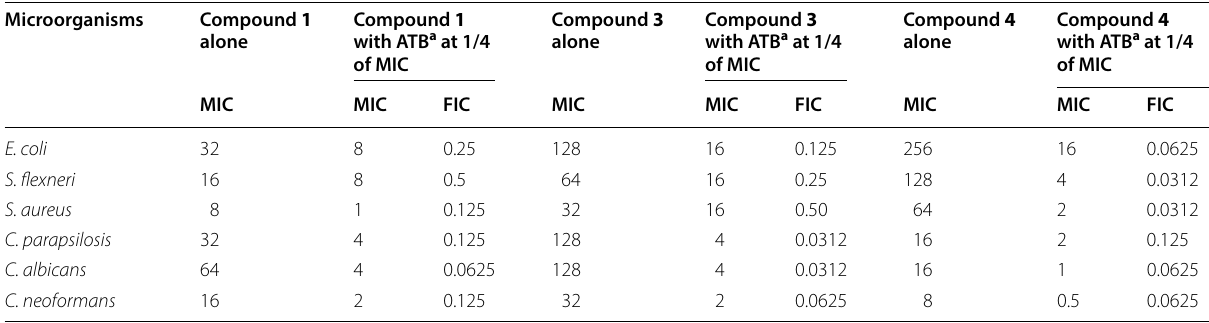
MIC minimal inhibitory concentration, FIC fractional inhibitory concentration, ATB antibiotics a Fluconazole for yeasts and tetracycline for bacteria were tested at the concentration of MIC/4 on the corresponding microorganism